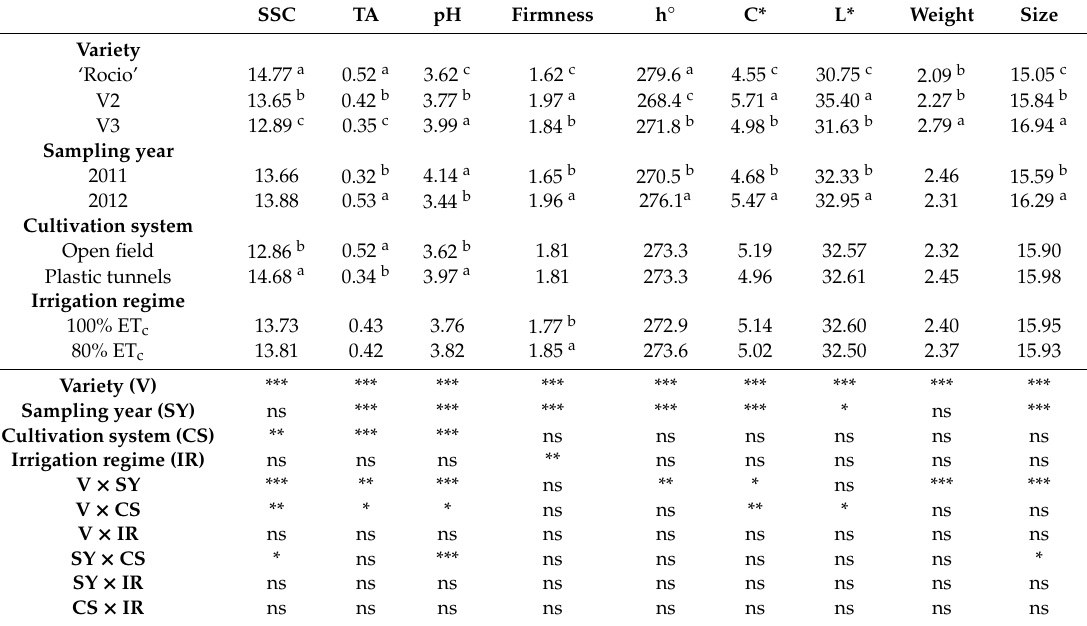
Table 1. E ff ect of variety, sampling year, cultivation system and irrigation regime on quality parameters of